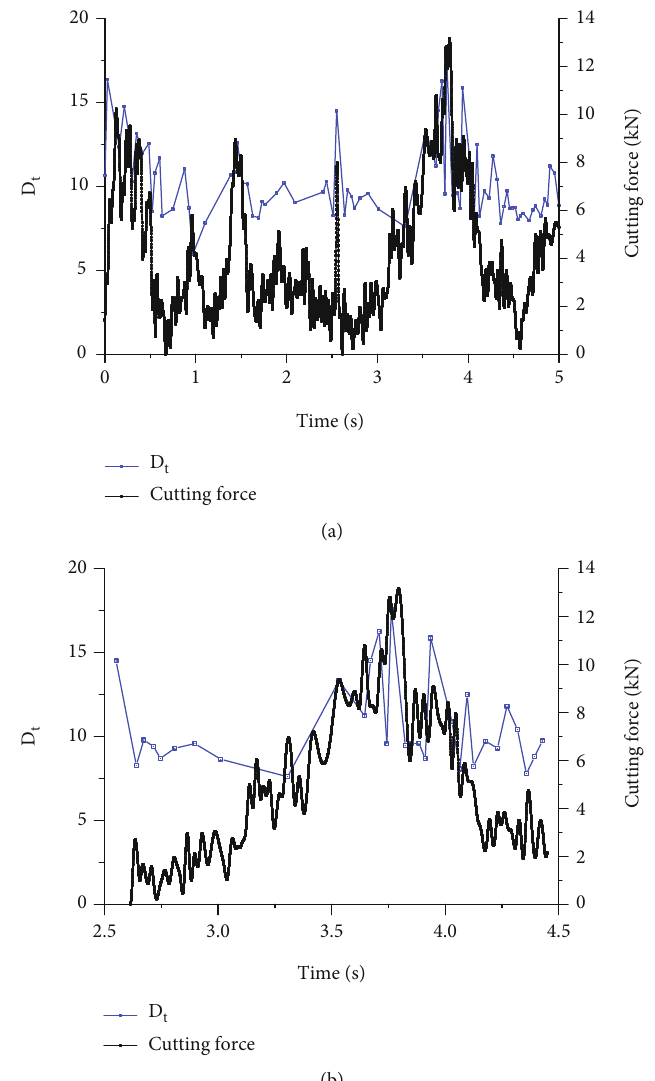
Figure 4: Time fractal dimension of acoustic emission energy of cutting H